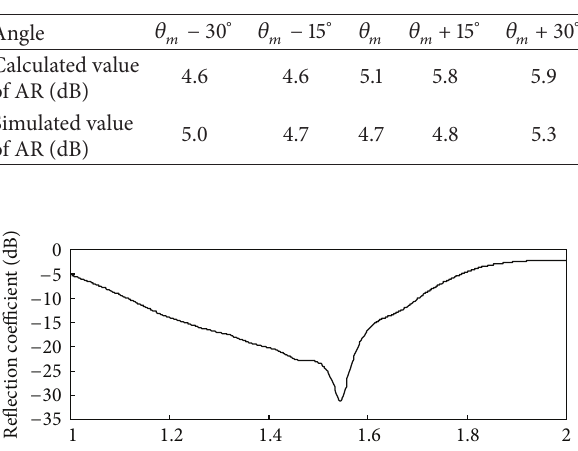
Table 3: Calculated and simulated results of axial ratio near the maximum radiation direction.